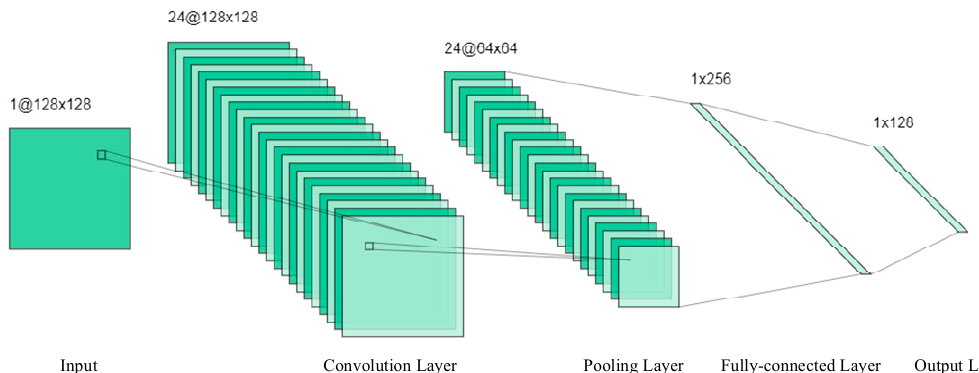
Figure 3. Simple convolutional neural network (CNN).